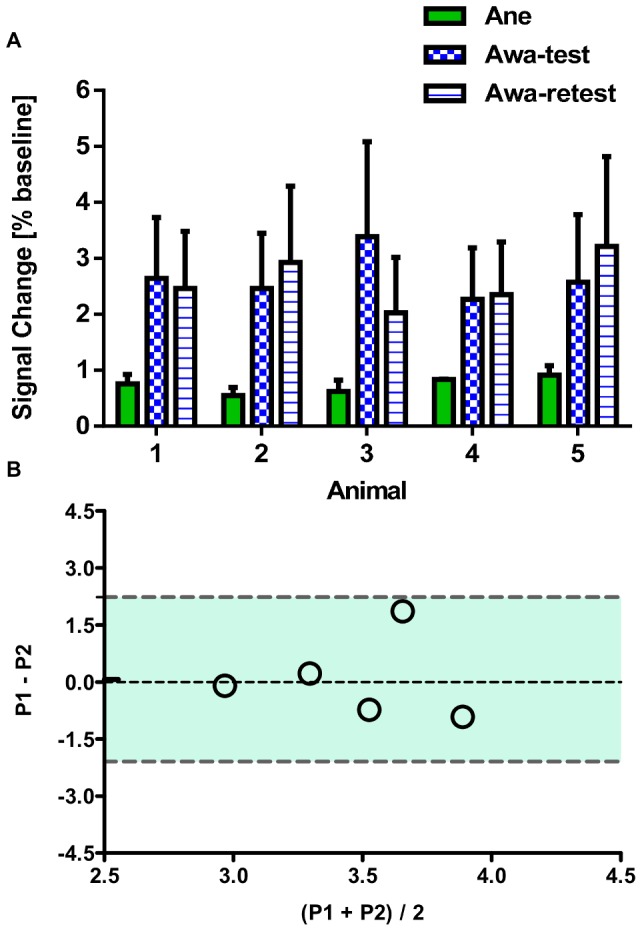
Comparison of resting state stability between anesthetized and awake imaging and test-retest reliability of awake baseline signal.(A) Resting state variation of BOLD signal (mean ± SD) obtained from each non-human primate (NHP) imaged under either awake (Awa, test and retest) or anesthetized (Ane) condition. (B) Bland-Altman plot for awake imaging data and the dash lines highlight the 95% limits of agreement (P1: represents the first test, P2 represents the retest).